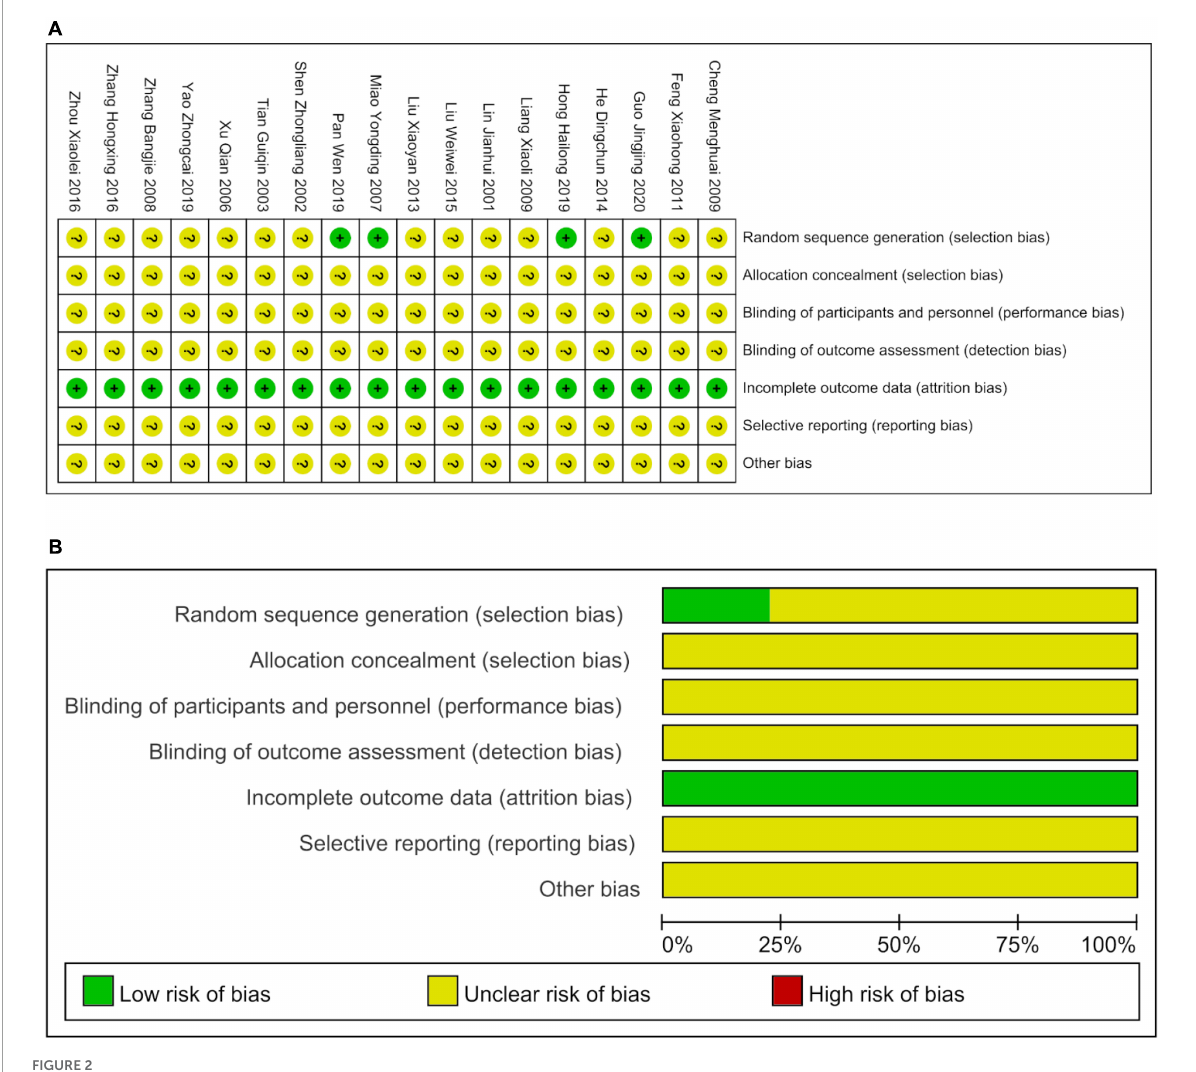
I 2 = 0%). There was no statistically significant